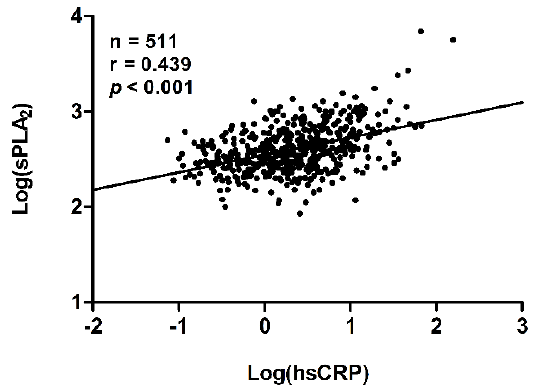
Figure 1. Correlation between plasma levels of log-transformed high sensitivity C-reactive protein (hsCRP) and log-transformed group IIA secretory phospholipase A 2 (sPLA 2 ). The regression line was fitted with linear regression. Pearson’s correlation coefficient is given.